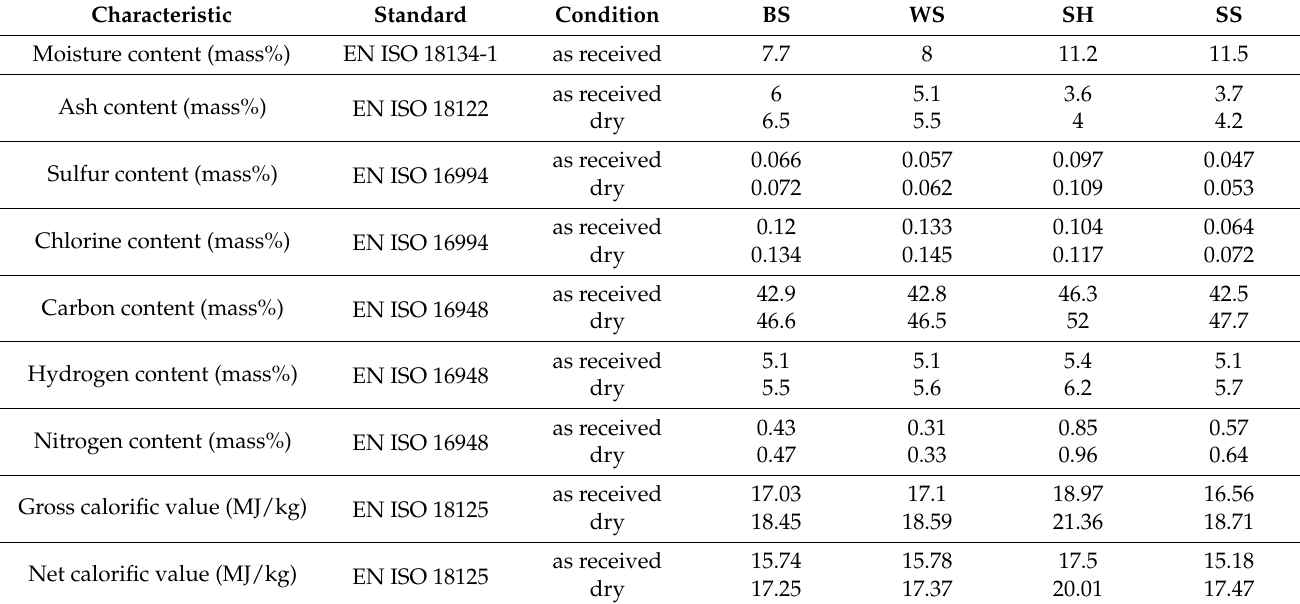
Table 1. Characteristics of agricultural biomass (barley straw—BS; wheat straw—WS; sunflower seed husks—SH; and soy straw—SS).